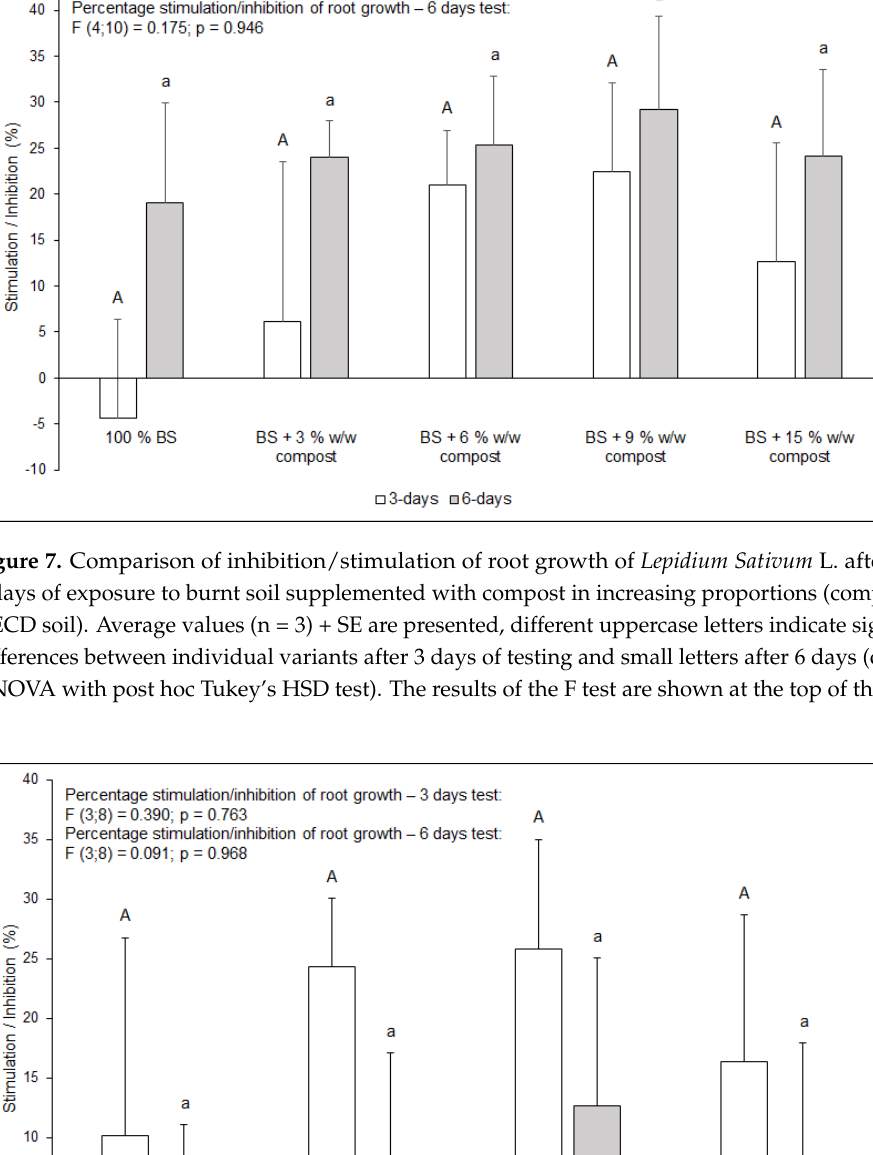
Table 6. Comparison of total average of stimulation/inhibition of root growth of Lepidium sativum L. after 3 and 6 days of exposure to burnt soil supplemented with compost in increasing proportions (compared to OECD soil).